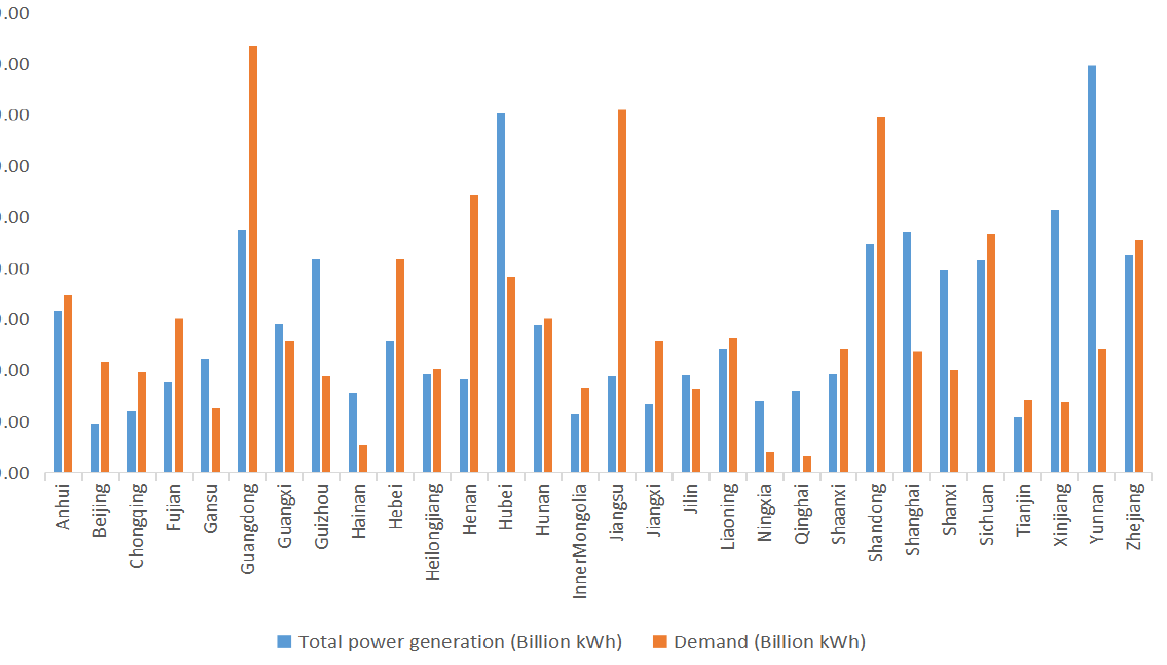
Figure 6. Power generation and demand by province.